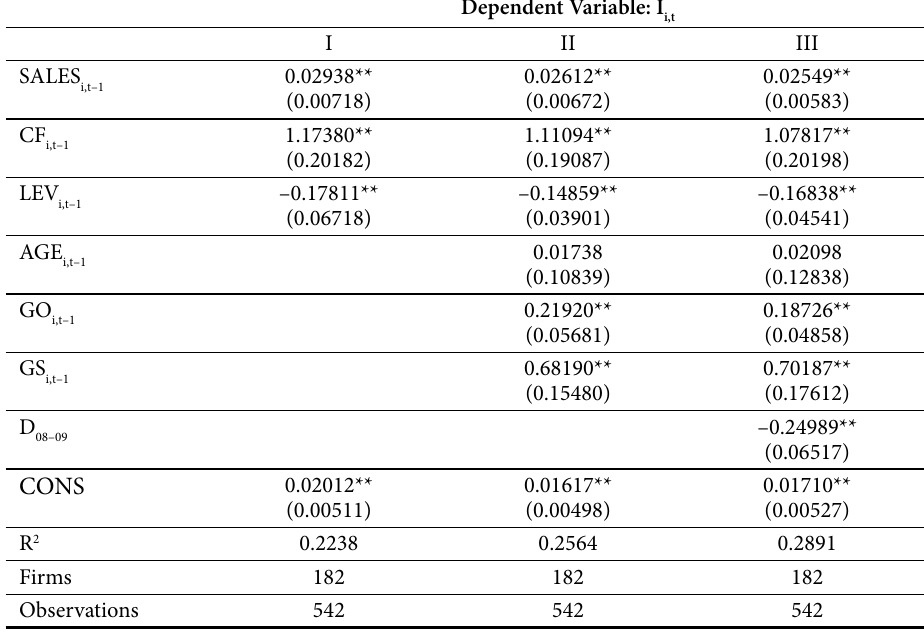
Table 5. investment determinants of fitness